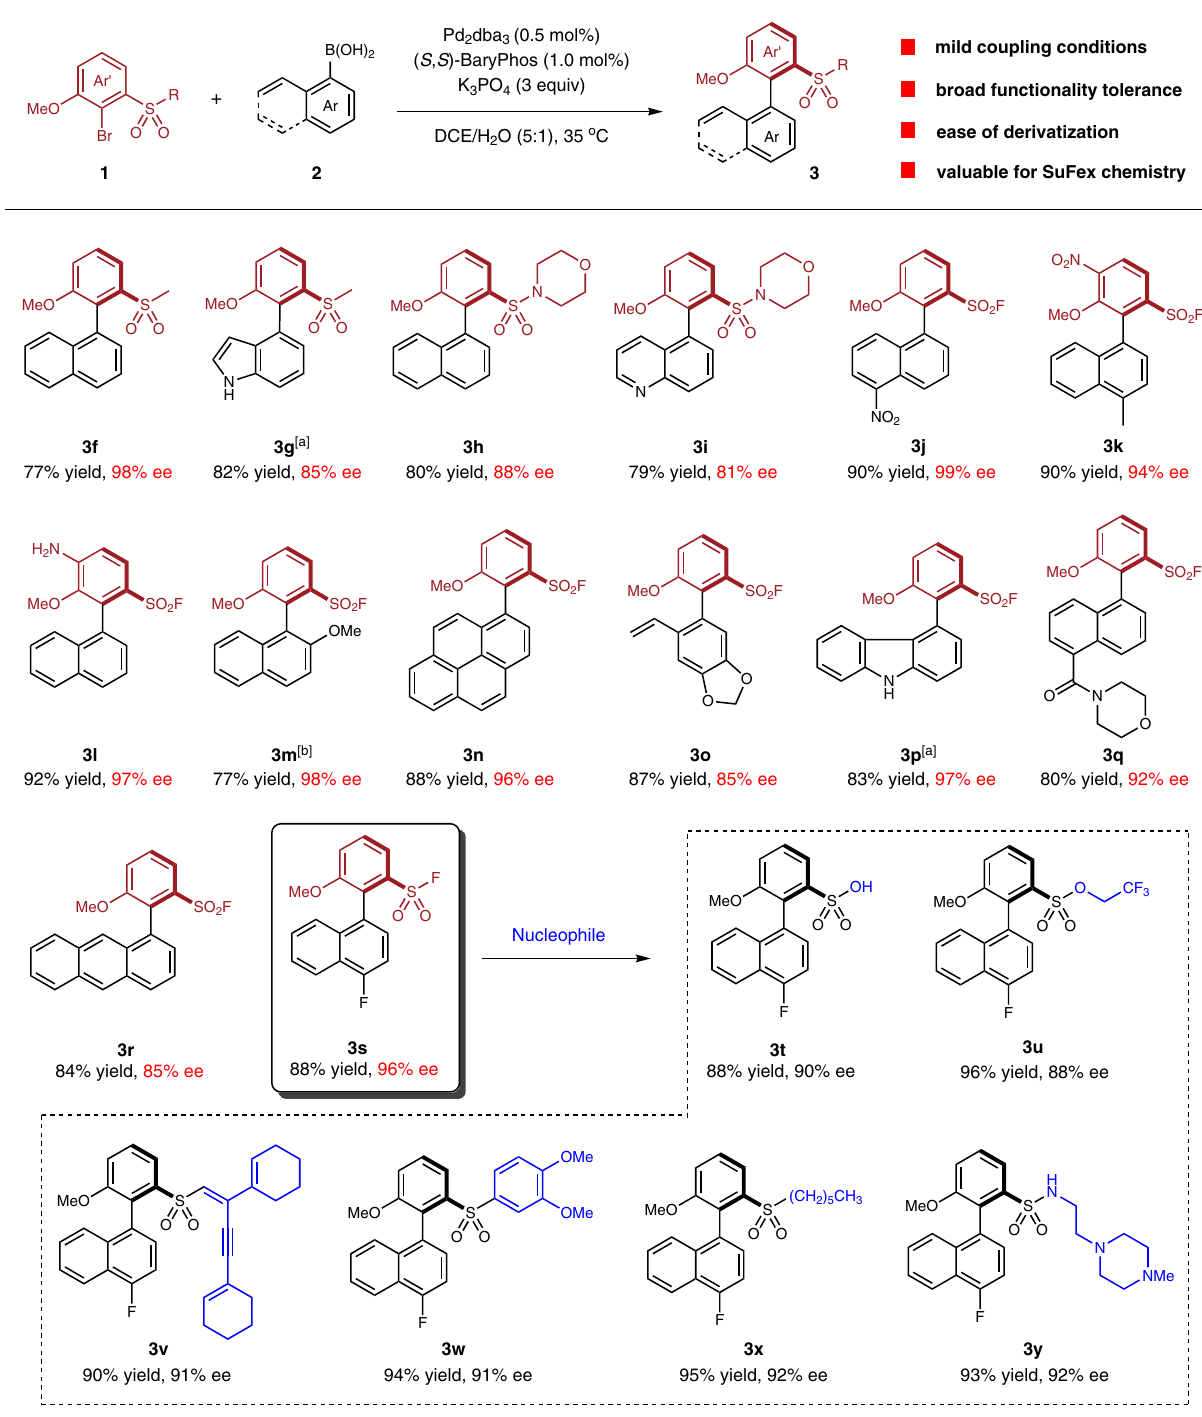
Fig. 3 | Synthesis of ortho sulfonyl-substituted axially chiral biaryls and post- transformationof3s. Detailsof thecross-couplingreactionsand derivatizationof 3s wereprovidedintheSupplementaryMethods1.4and1.9,respectively;theyields refer to isolated yields; the ee value was determined by HPLC; The absolute